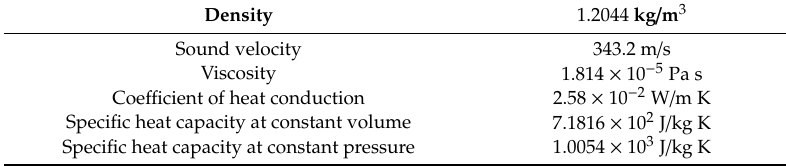
Table 1. Air parameters at a temperature of 20 ◦ C and a static pressure of 1013 hPa